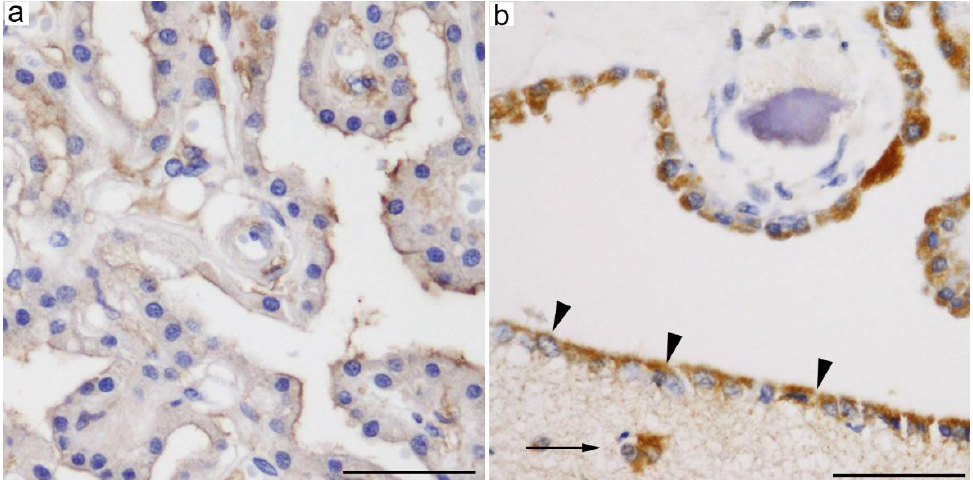
Figure 3. Representative microphotographs of immunohistochemical staining for ( a ) GLUT5 (18905, IBL, Takasaki, Japan) [111] and ( b ) GLUT8 (bs-4241R, Bioss) [28] in human CP. ( a ) GLUT5 is mainly located in the apical side of CP epithelial cells. ( b ) Intracytoplasmic granular immunoreactivity for GLUT8 is observed in CP epithelial cells, as well as in ependymal cells (arrowheads) and subependymal glial cells (arrow) [112]. Scale bars: 50 μm.